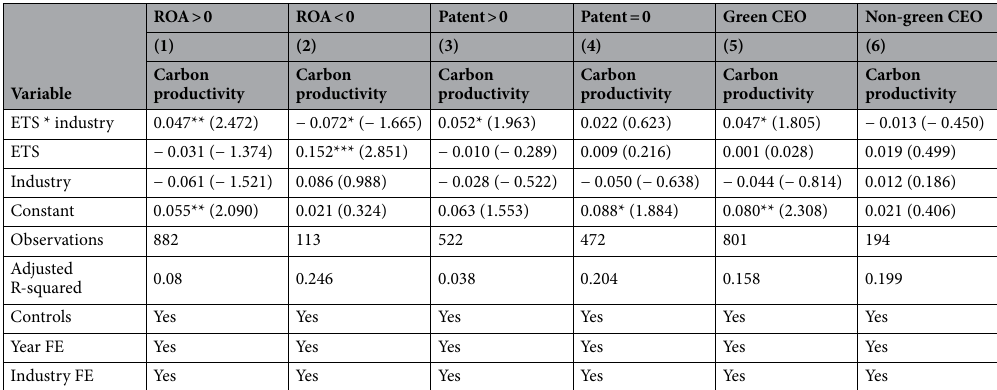
Table 3. Estimated effects of firm size, R&D intensity, and board characteristics on carbon productivity as determined by regression analyses. Parentheses present t-values based on standard errors clustered by firm. *, **, and *** indicate significance at the 10%, 5%, and 1% levels,